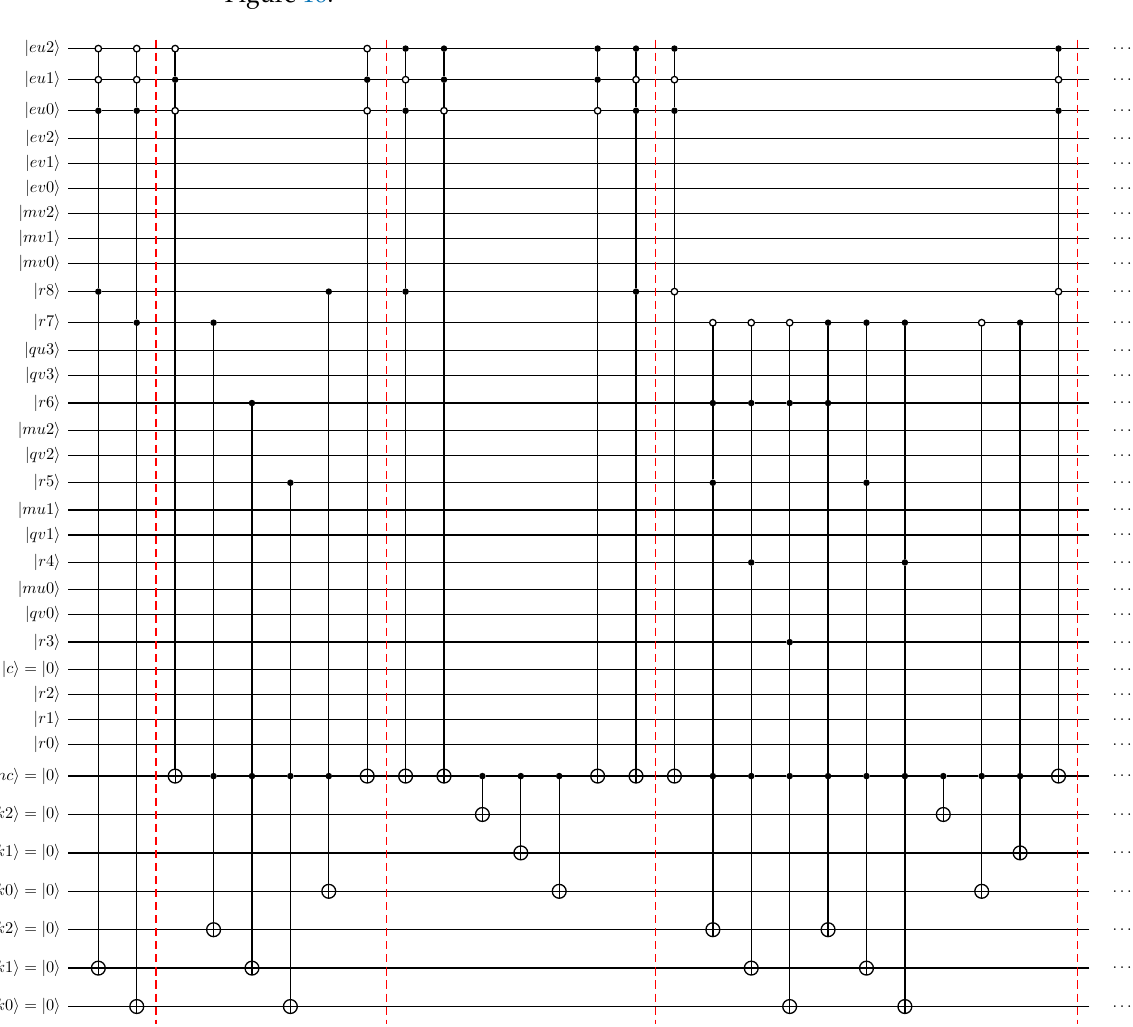
= eu 2 eu 1 eu 0 110 are accounted for in the third block of gate operations in | | | (cid:105) | (cid:105)